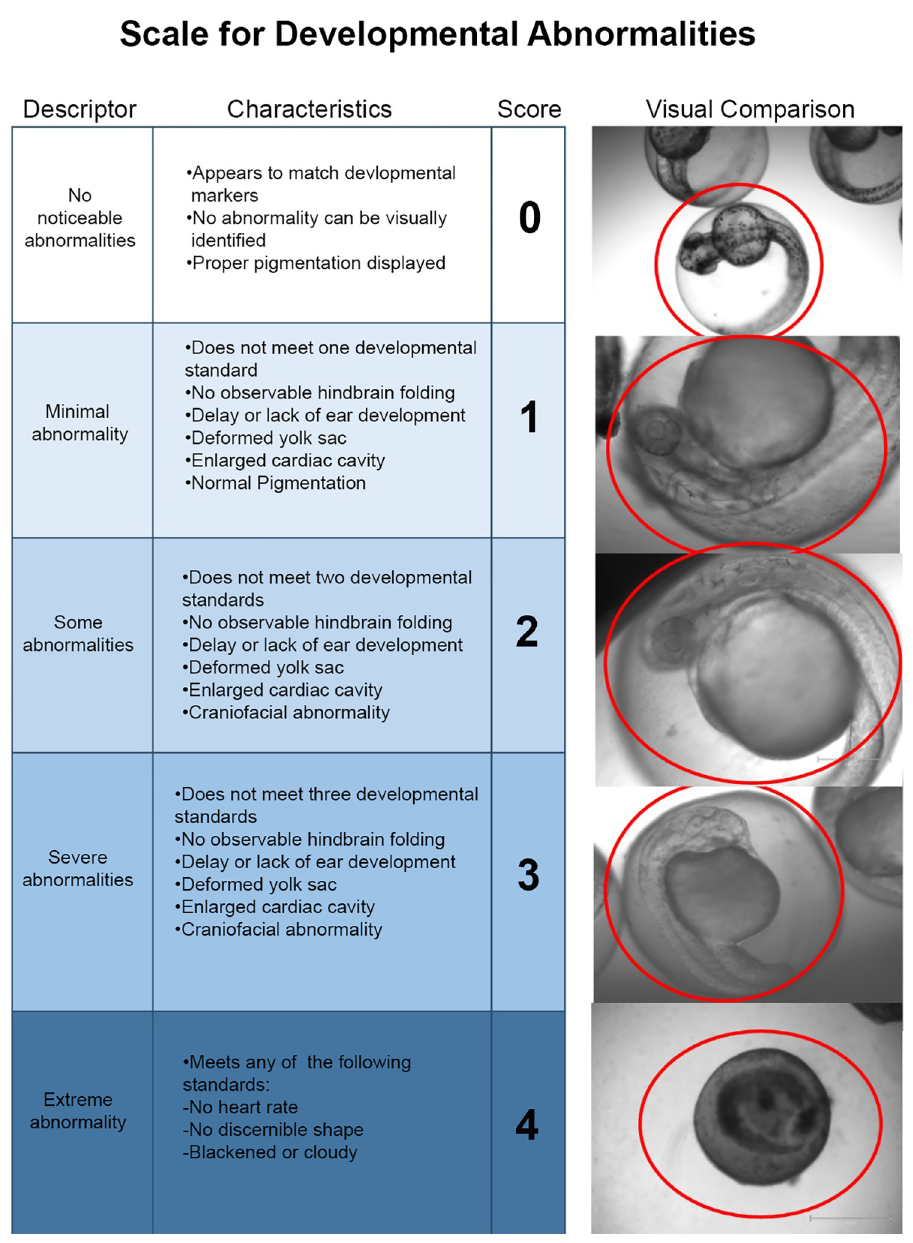
Fig 1. Semi-quantitative scale developed to assess morphological changes following treatment of zebrafish embryos with an amino-terminal fragment of nApoE4 1-151 . Rubric for developmental abnormalities was accomplished in 48 hpf zebrafish following 24-hour treatment with 25 μ g/ml of nApoE41-151. This scale was established to quantify the effects of nApoE4 1-151 as compared to untreated, control embryos. Identified hallmark defects that appeared consistently following treatment with nApoE4 1-151 included inflation of pericardial cavity, enlarged hearts, pigmentation alterations, and delays or lack of development in ear and brain structures. Data are representative of 10 embryos treated with 25 μ g/ml nApoE4 1-151 per trial for a total of 30 embryos. nApoE4 at a final concentration of 25 μ g/ml. Data analyzed for each trial represent the aver- 1-151 aged results for each collection date. Data was analyzed through two-way ANOVA modeling with three treatment groups (Control, nApoE3 , and nApoE4 ) in R statistical software. 1-151 1-151 The ANOVA model was assessed for assumptions after creation of model in R.